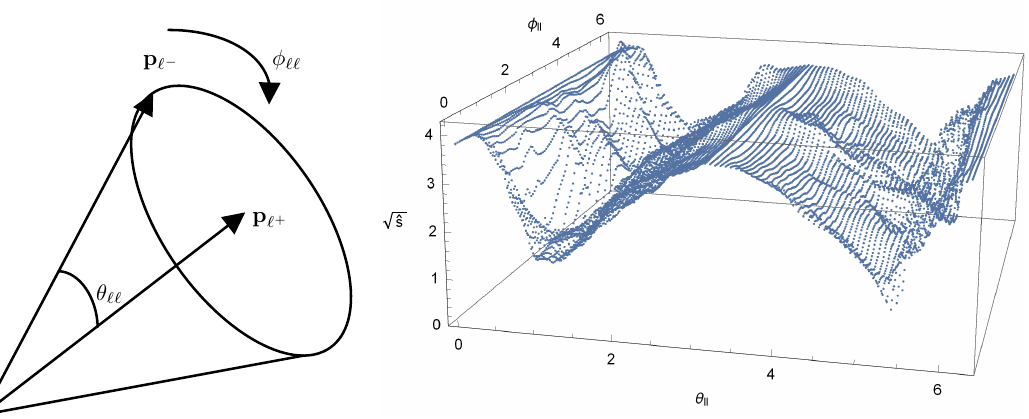
− θ ) (the left panel) and ‘ + ‘ −